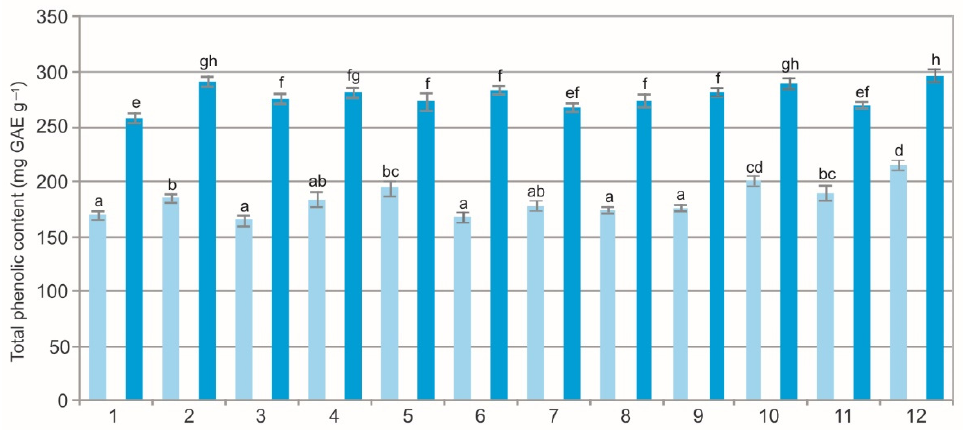
Figure 1. Total phenolic concentration in water (light blue) and ethanol (dark blue) leaf extracts from bearberry plants in different populations. The values designated by the different letters are significantly different ( p < 0.05).